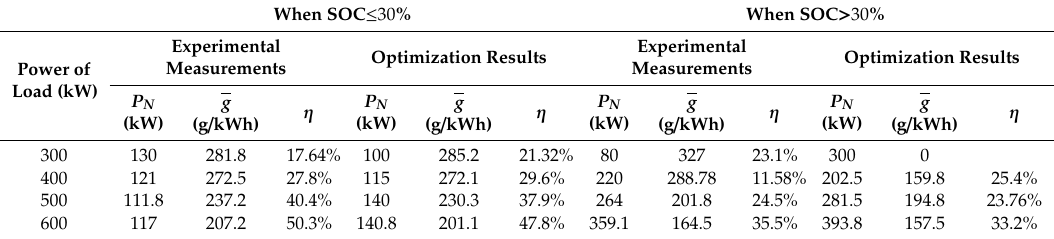
Table 3. The ship’s specific fuel consumption and diesel generator’s e ffi ciency: experimental measurements versus optimization results. When SOC ≤ 30 % When SOC > 30 % Experimental Experimental Optimization Results Optimization Measurements Measurements Power of Load (kW)